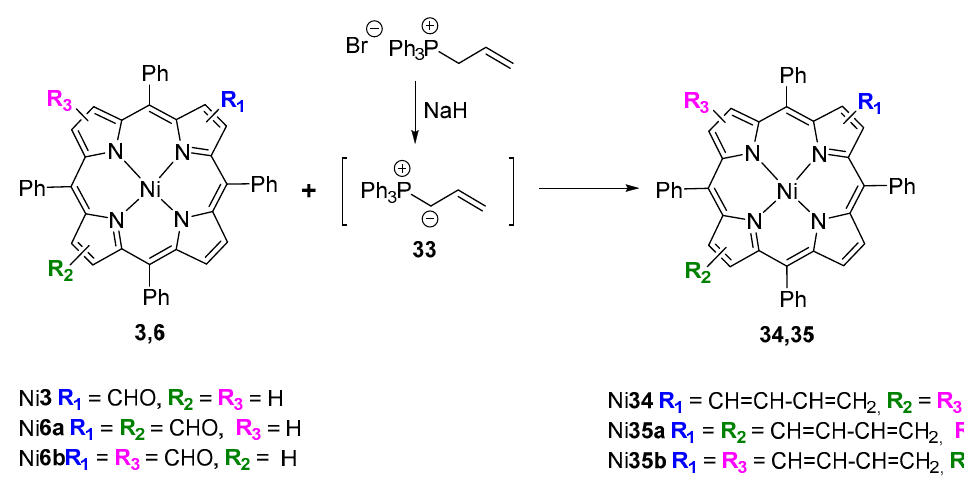
Scheme 12. Synthesis of β -butadienyl- and β , β′ -di(butadienyl)porphyrins